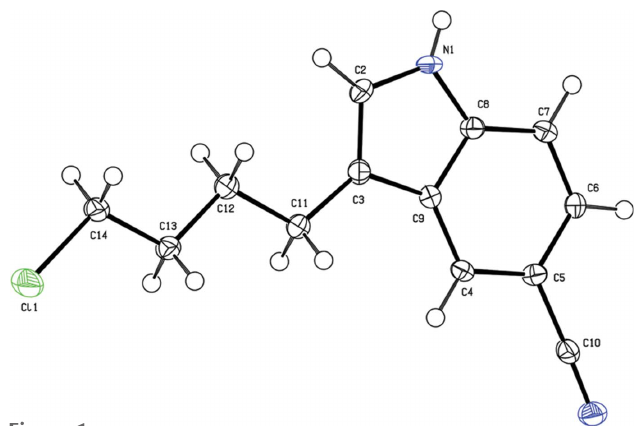
Figure 1 The asymmetric unit of (I), shown with 50% probability displacement ellipsoids. neighboring molecules self-assemble through weak C—H (cid:2) (cid:2) (cid:2) Cl interactions (Table 1), forming zigzag supramolecular C (9) chains extending along the b -axis direction, as shown in Fig. 2 a .’ should be replaced by ‘In the crystal, neighboring molecules self-assemble through N—H (cid:2) (cid:2) (cid:2) N and weak C—